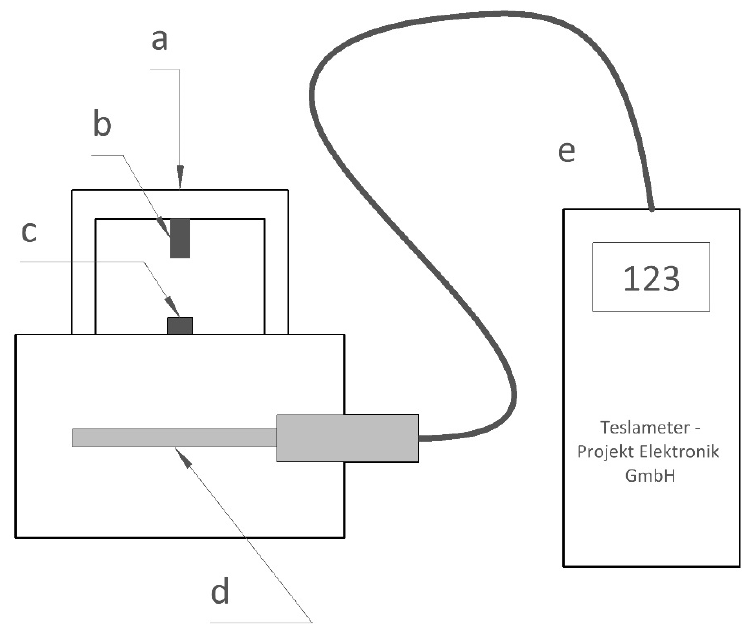
Figure 6. Measuring magnetic properties of a PCD. a: Magnet support, b: ∅ 5 mm by 8 mm Nd alloy magnet, c: PCD blank, d: probe, e: handheld teslameter.